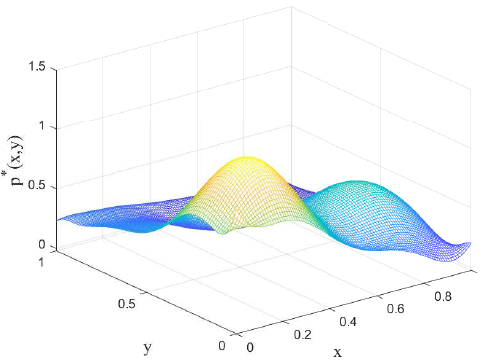
Figure 11. The approximation function p ∗ ( x , y ) on [ 0,1 ] × [ 0,1 ] .